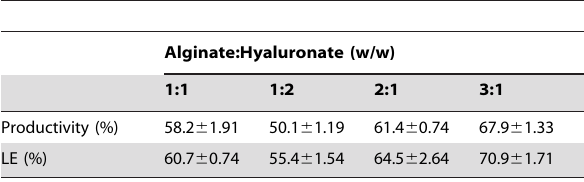
Table 2. Comparison of different mass ratio between alginate and hyaluronate a .